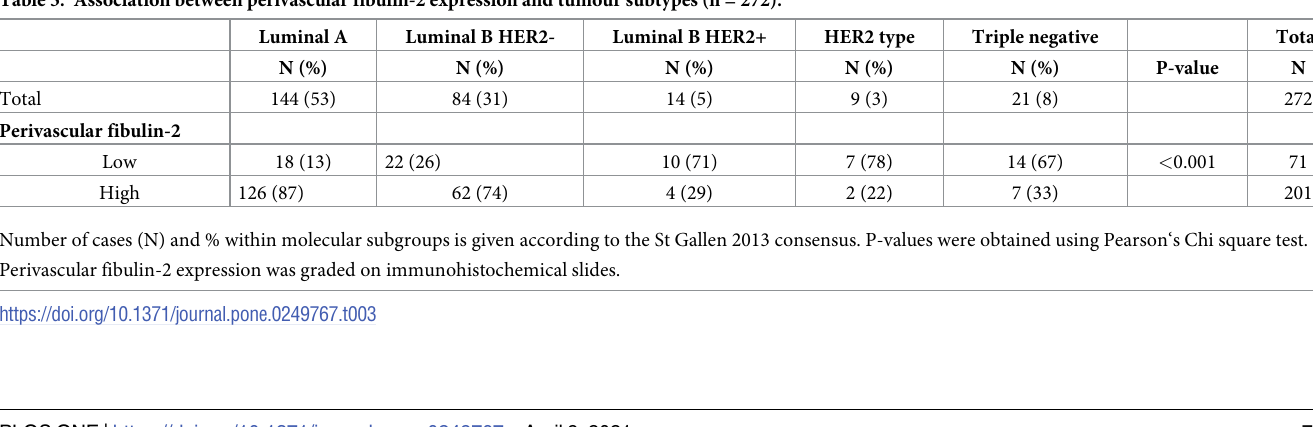
Table 3. Association between perivascular fibulin-2 expression and tumour subtypes (n = 272). Luminal A